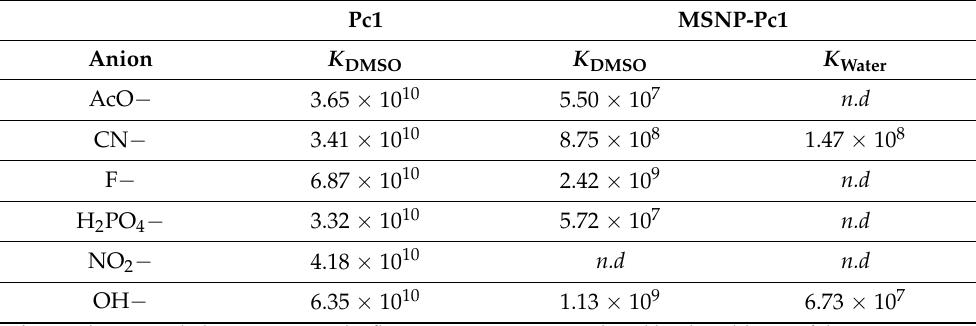
Table 1. Anions binding constants K (M − 1 ) found for Pc1 and MSNP-Pc1 in DMSO and water.